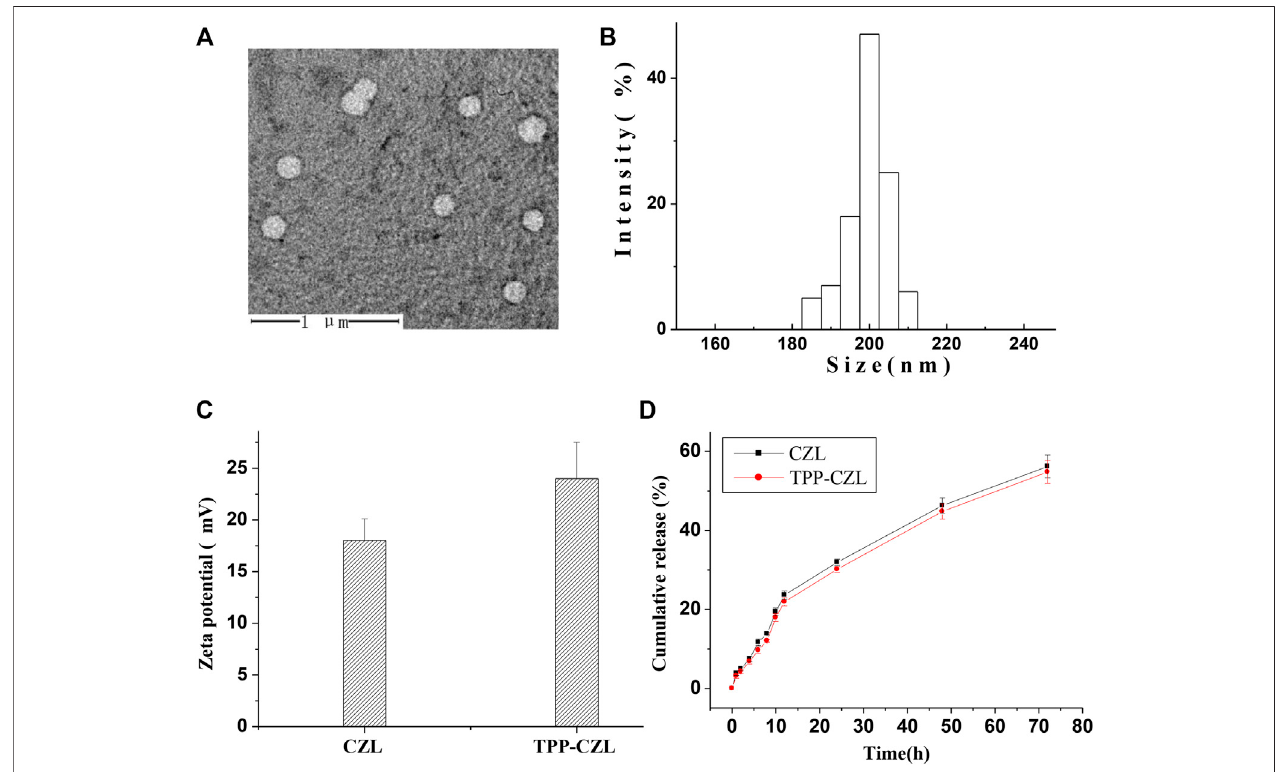
FIGURE 3 | Cell uptake rate of curcumin/CZL and curcumin/TPP-CZL. * p < 0.05, ** p < 0.01, *** p < 0.001 compared with CZL group.